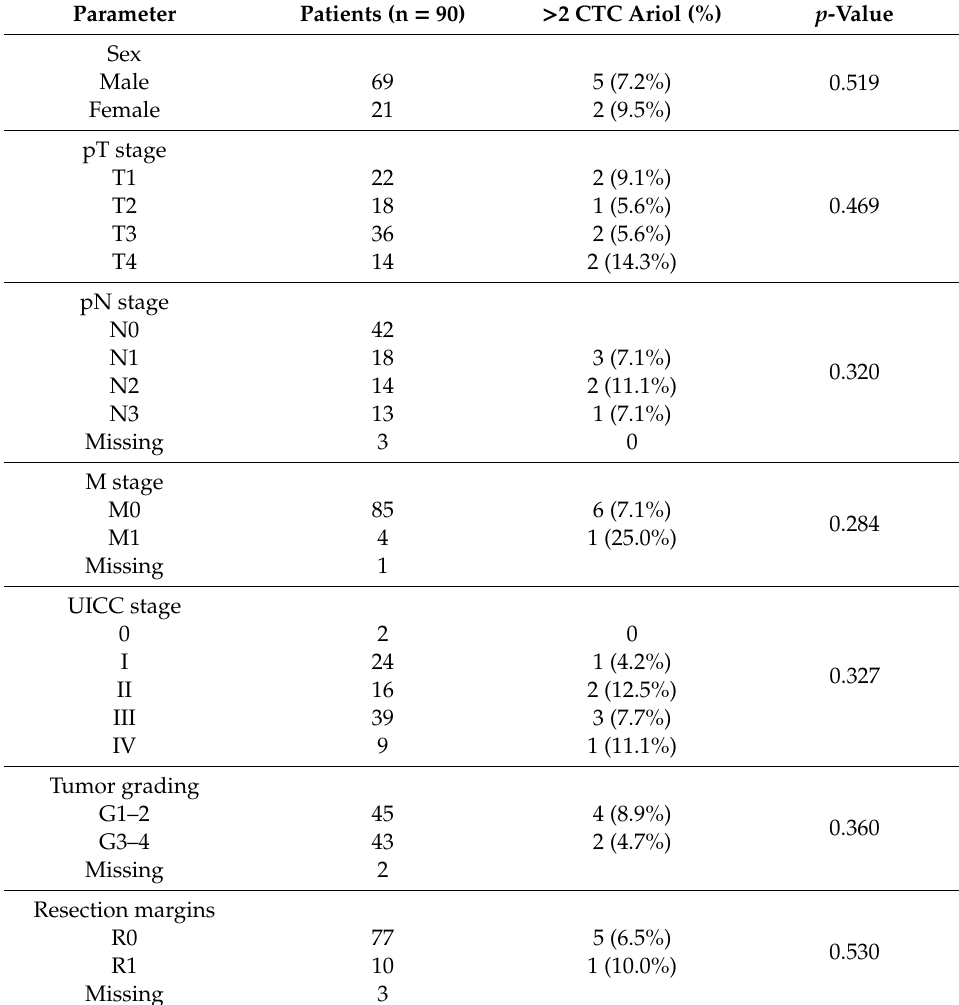
Table 1. Correlation between histopathologic parameters and CTCs detected by Magnetic Cell Separation (MACS) enrichment / Ariol. Missing refers to the respective test